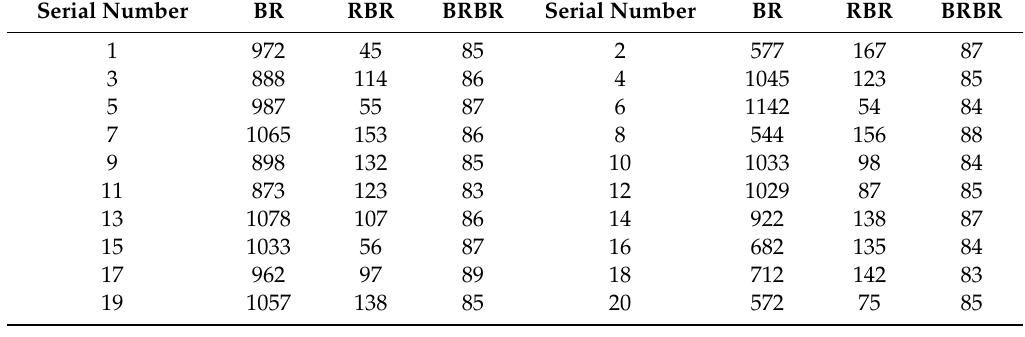
Table 5. First response time comparison of three retrieval algorithms (unit: ms).